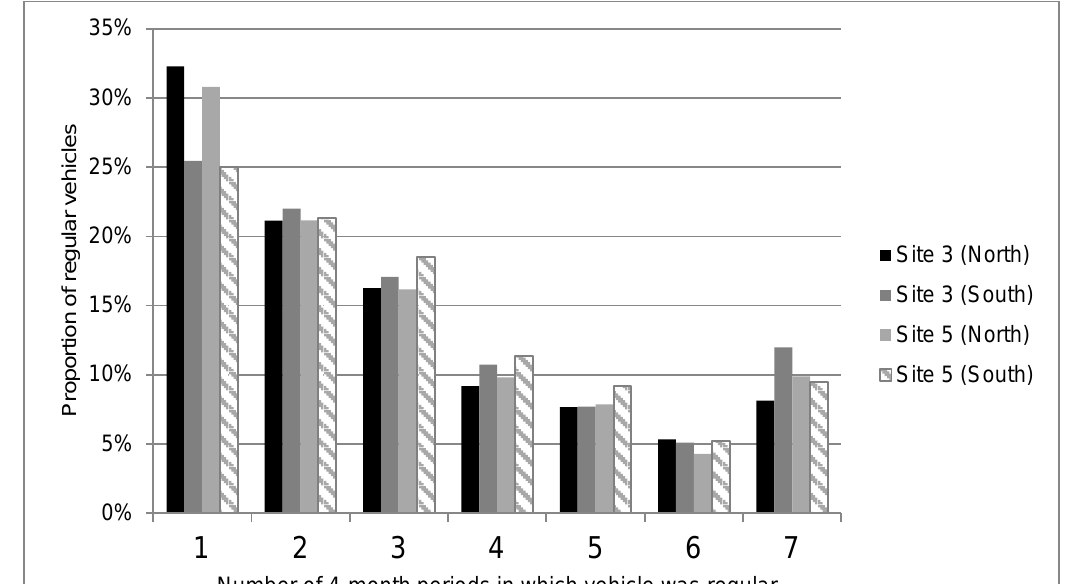
Figure 7. Regularity